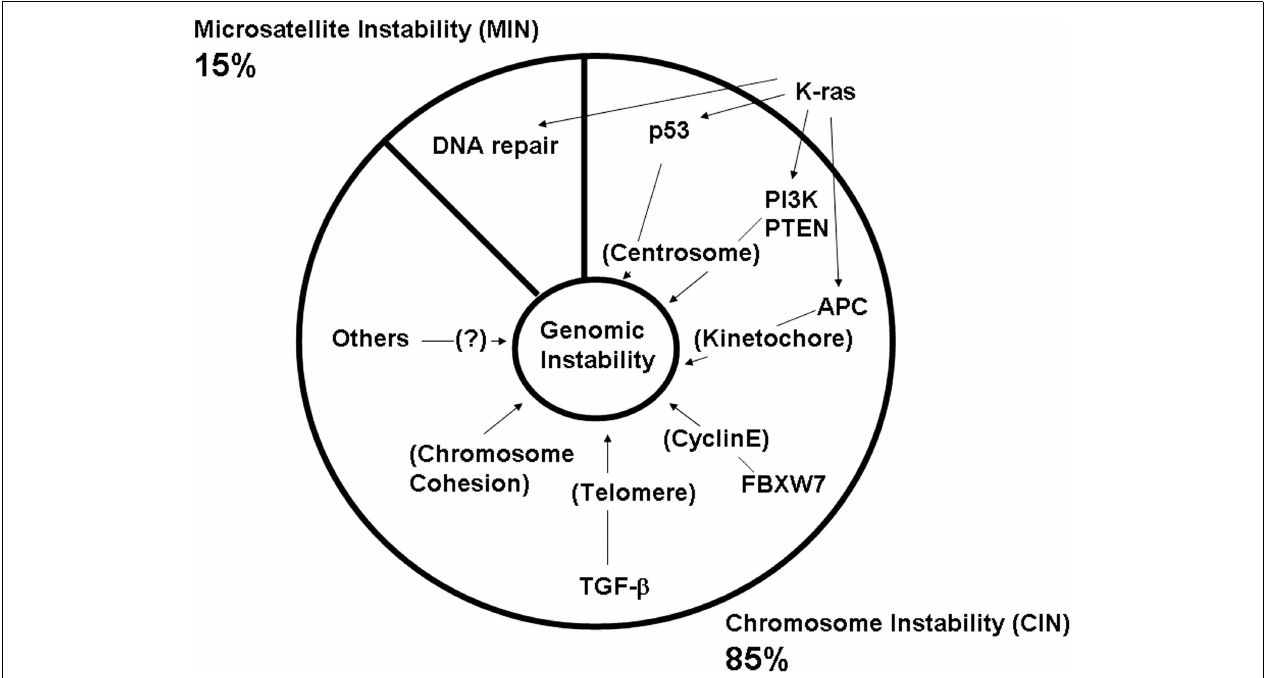
p53, PI3K, APC, FBXW7,TGF- β , and chromosome cohesion. Studies have indicated that each CAN gene mutation can lead to genomic instability either by itself or in concert with other mutations (see text).This effect would explain why nearly all advanced colon cancers show a high degree of genomic